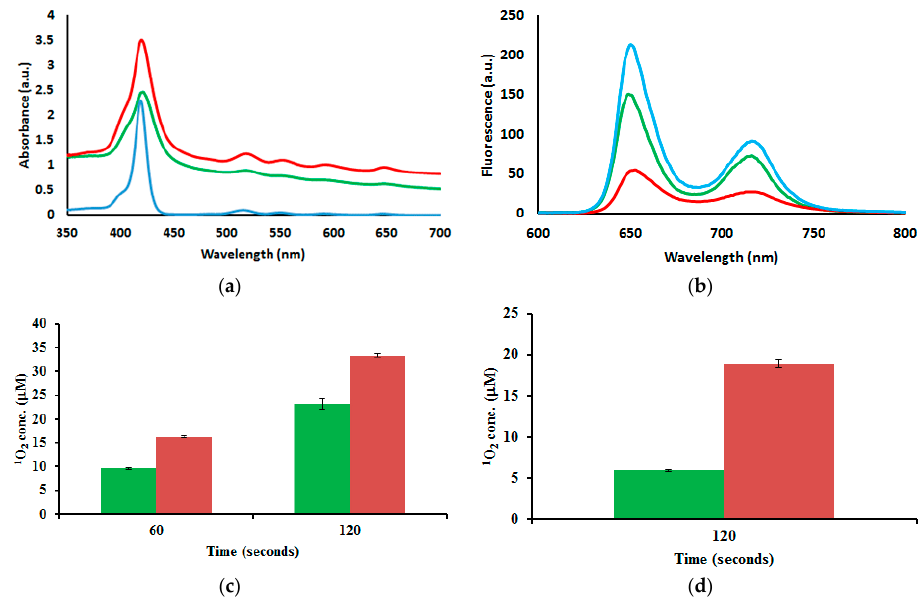
Figure 3. Photophysical and photochemical properties of C-TCPP- and RR-TCPP-PSilQNPs. ( a ) UV-vis spectroscopy of 2 (blue), C-TCPP- (green) and RR-TCPP-PSilQNPs (red); and fluorescence spectroscopy ( b ) of 2 (blue), C-TCPP- (green) and RR-TCPP-PSilQNPs (red). Determination of 1 O 2 production by C-TCPP- (green) and RR-TCPP-PSilQNPs (red) after irradiation with white ( c ) and red ( d ) light. Error bars represent the standard deviation of three independent experiments.